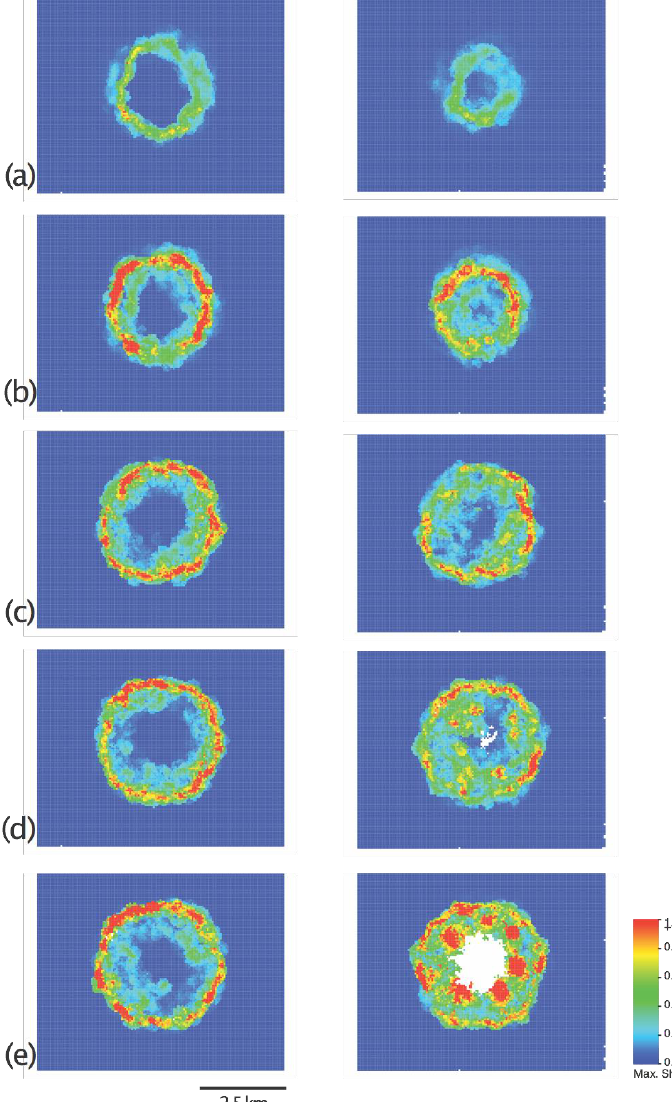
Figure 7. Evolution of horizontal sections C (left) and D (right): incremental shear strain accrued during the preceding 200 m of basal subsidence at ( a ) 200, ( b ) 400, ( c ) 600, ( d ) 800, and ( e ) 1000 m basal subsidence for an experiment with a flat, circular roof.